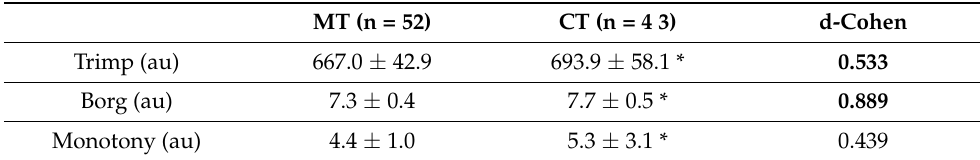
Table 1. Variables used to control training stimuli.